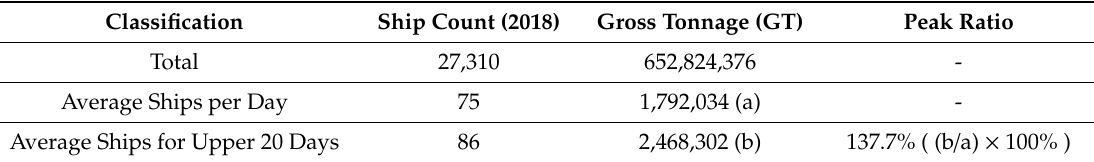
Table 8. The Peak Ratio of Gross Tonnage of Calling Ships in Busan Port.